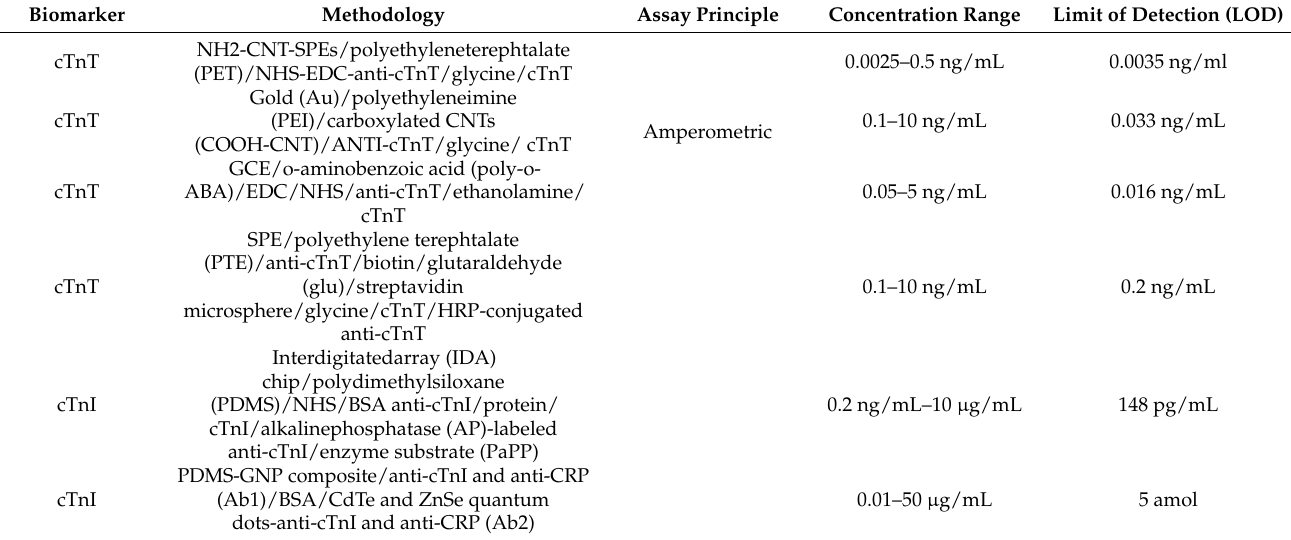
Table 1. List of electrochemical solutions capable of measuring troponin levels. Adapted from [7,8].